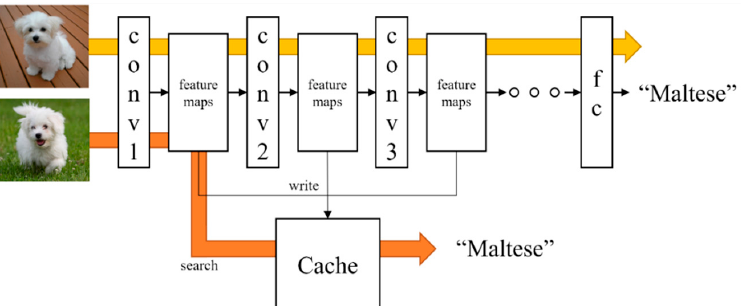
Figure 1. Proposed cached CNN structure. The yellow line indicates the flow in which the input image is classified by the CNN. The red line indicates the flow in which input image is classified by the cache.